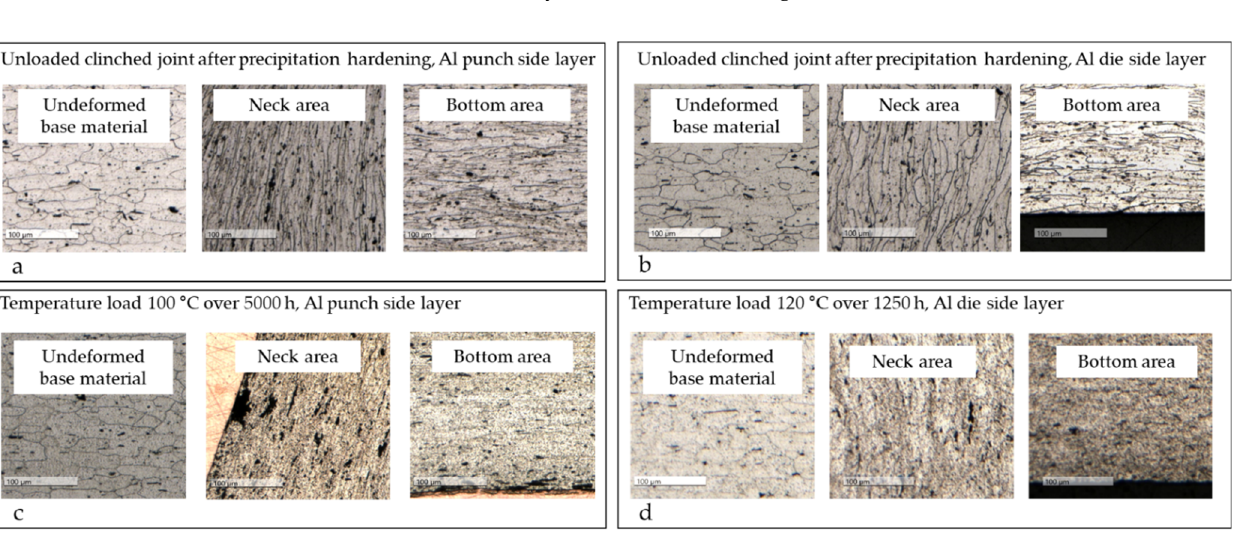
duced, which results in less deformation of the crystallites (Figure 12b).